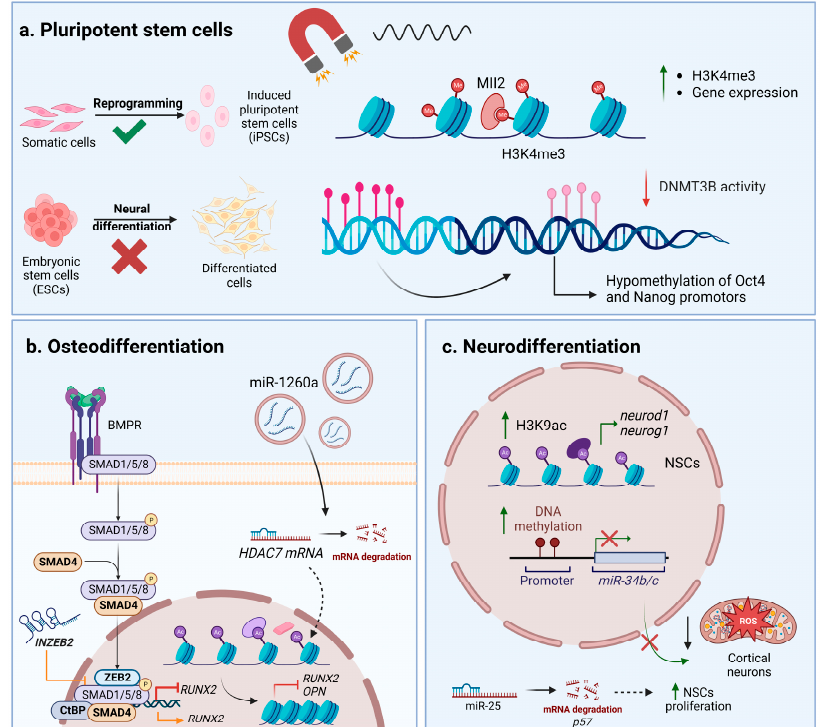
Figure 2. Epigenetic and noncoding RNAs’ control in stem cells exposed to magnetic materials and magnetic fields. ( a ) Influence on pluripotent stem cells. ( b ) Changes during osteodifferentiation. ( c ) Changes during neurodifferentiation. Abbreviations: bone morphogenetic protein receptor— BMPR; C-terminal-binding protein—CtBP; DNA methyltransferase 3B—DNMT3B; embryonic stem cells—ESCs; induced pluripotent stem cells—iPSCs; histone 3 lysine 24 trimethylation—H3K24me3;